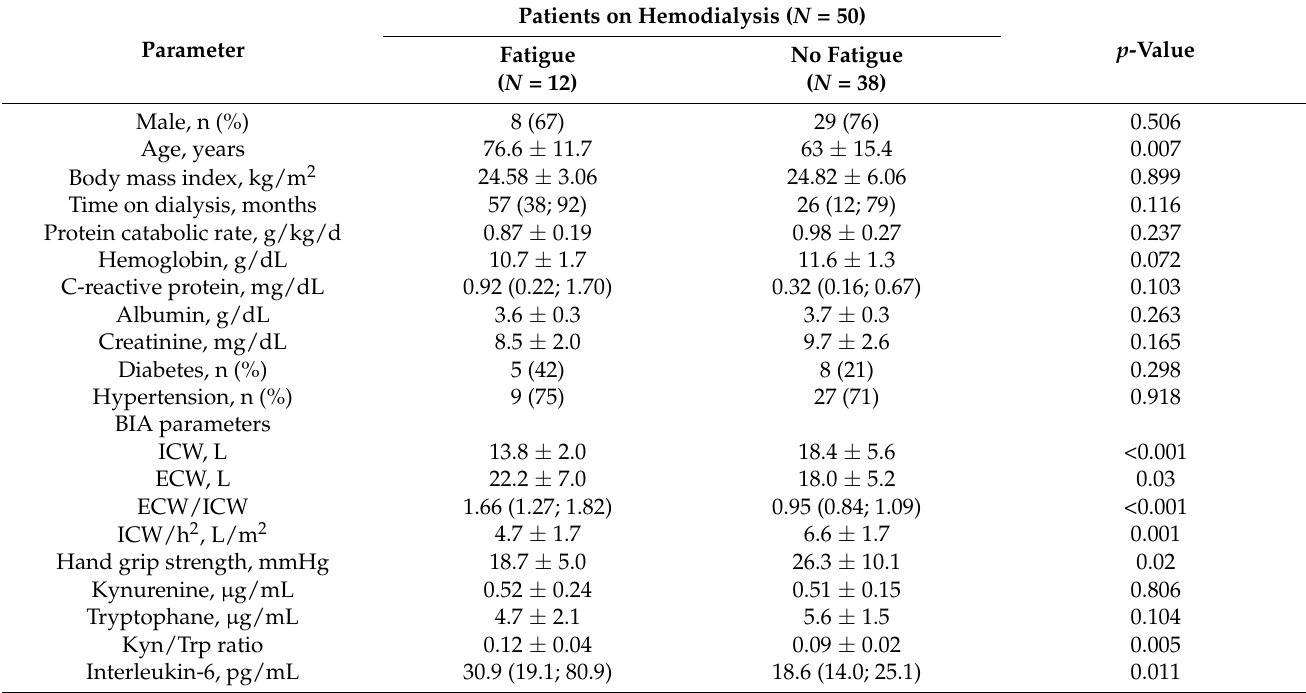
Table 1. Patient’s characteristics.